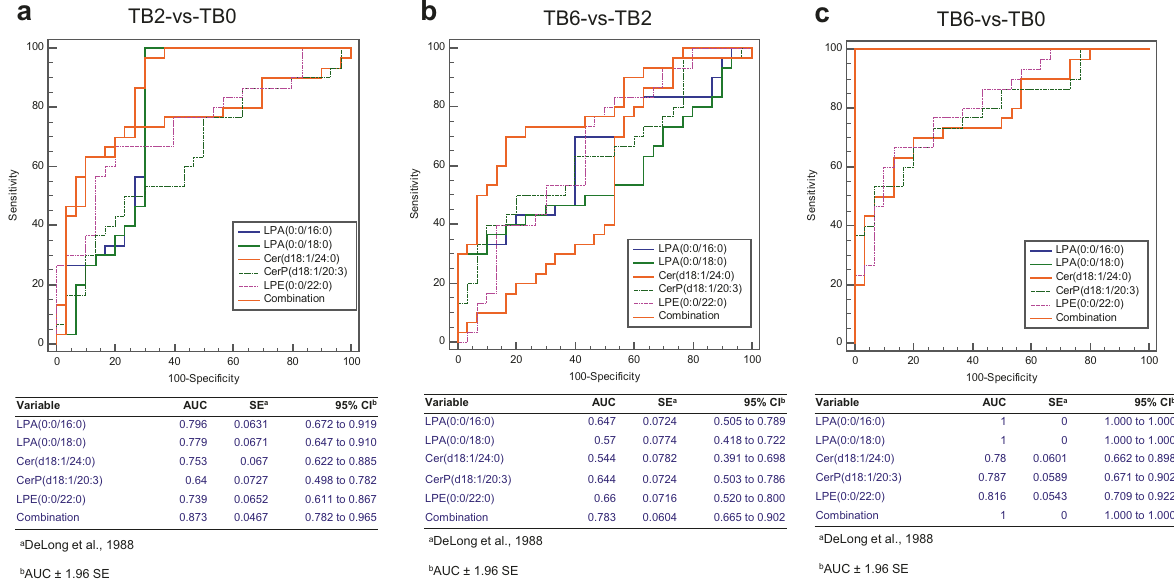
Fig. 6 Evaluation of fi ve differential lipid metabolites on the therapeutic effect of active TB treatment. a ROC curve was used to distinguish the patients in the TB2 and TB0 groups, the area of the panel under the curve (AUC) was 0.873 (95% CI, 0.782 – 0.965). b ROC curve was used to distinguish patients in the TB6 and TB2 groups, the area of the panel under the curve (AUC) was 0.783 (95% CI, 0.665 – 0.902). c In addition, the ROC curve was used to distinguish patients in the TB6 and TB0 groups, the area of the panel under the curve (AUC) was 1.000 (95% CI, 1.000 – spectrometry. The signal intensity of characteristic ions was obtained in the detector. MultiQuant was used to integrate and calibrate the chromatographic peaks. The peak area of each chromatographic peak represented the relative content of the corresponding substance.